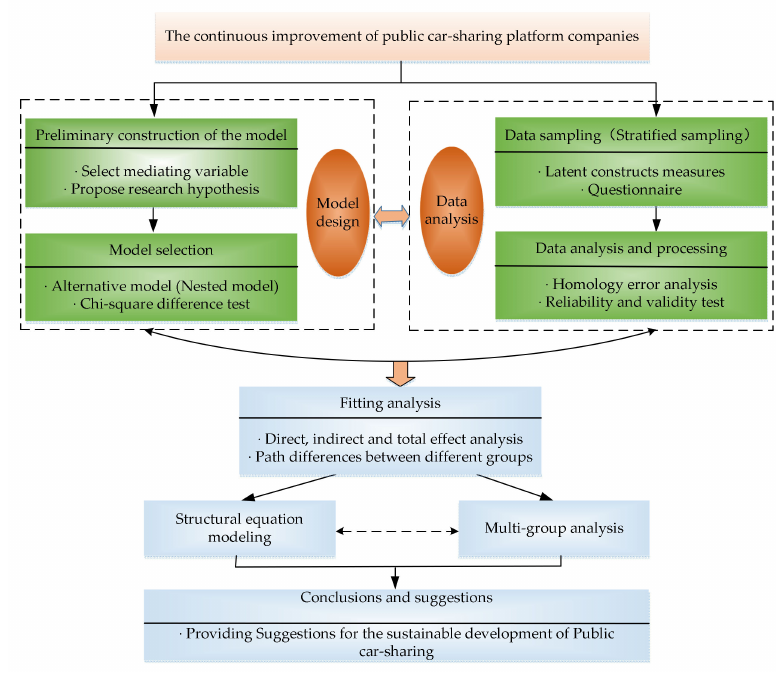
Figure 1. The research